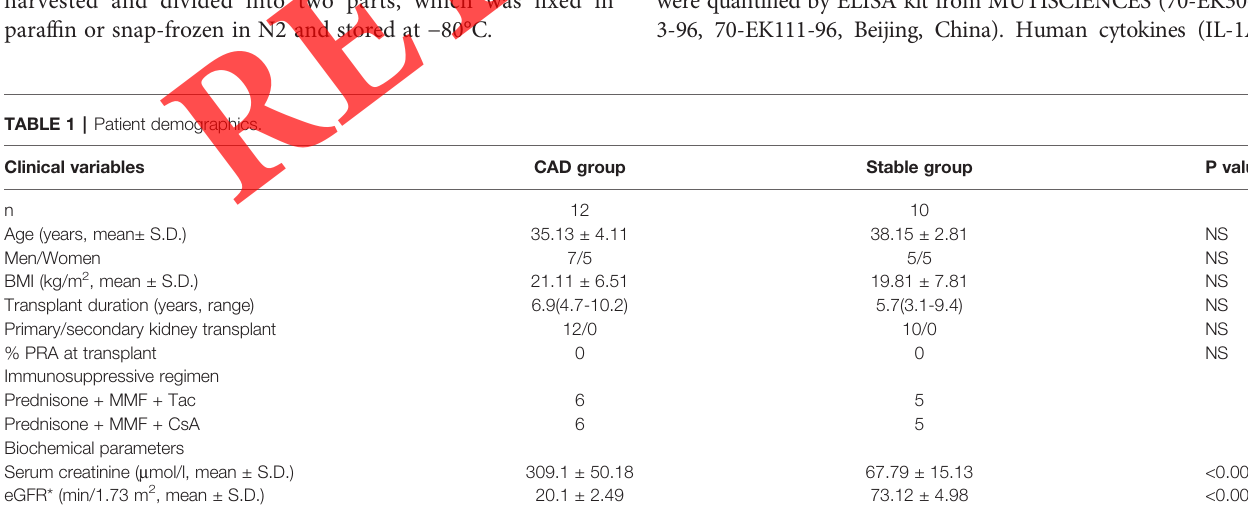
TABLE 1 | Patient